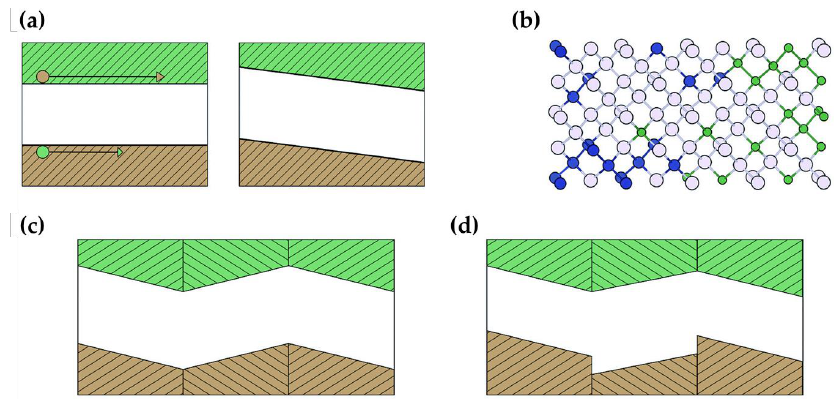
Figure 4. Conventional models for the polycrystalline anomalous photovoltaic effect [27]. Copyright 2015, Royal Society of Chemistry.